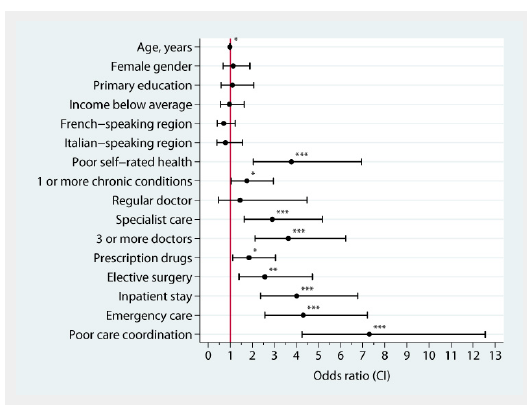
Bivariate associations between demographic, health and health care utilisation variables and report of any medical or